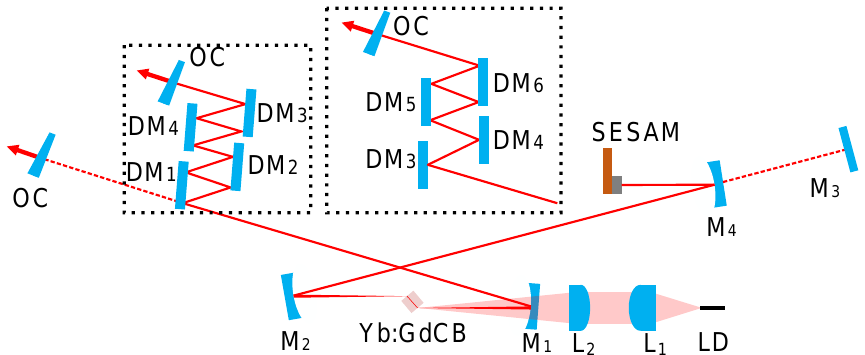
Figure 1. Schematic of the Yb:GdCB laser. LD: fiber-coupled laser diode; L 1 : aspherical lens; L 2 : achromatic doublet lens; M 1 , M 2 and M 4 : concave mirrors; M 3 : flat rear mirror for CW operation; DM 1 –DM 6 : dispersive mirrors; OC: output coupler; SESAM: SEmiconductor Saturable Absorber